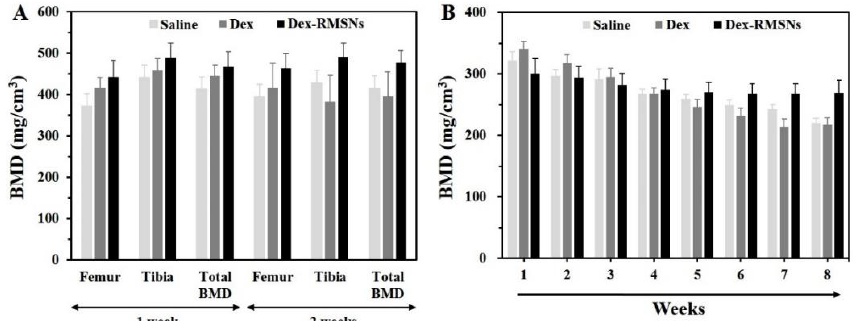
Figure 8. BMD of a femur and tibia after 1 week and 2 weeks in rheumatoid arthritis rats injected with saline, Dex, and Dex-RMSNs ( A ). BMD of the patella after 1 to 8 weeks in rheumatoid arthritis rats injected with saline, Dex, and Dex-RMSNs ( B ) ( n = 6, mean ± standard deviation).